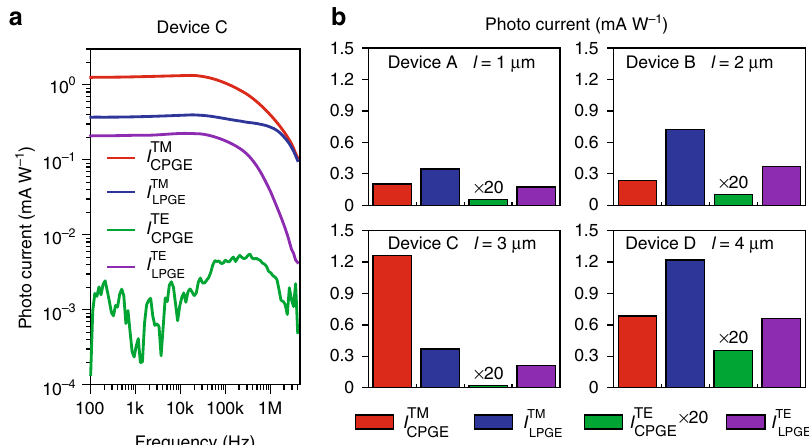
Fig. 4 Contributions of circular and linear photogalvanic currents. a Frequency response of the extracted CPGE and LPGE contributions of photogalvanic current for TM and TE modes in Device C. b CPGE and LPGE contributions for TM and TE modes in four devices with different TI lengths l between the electrodes from 1 to 4 µ m. A large variation of the ratio between the CPGE and the LPGE contributions is attributed to the high anisotropy of the LPGE, which is sensitivity to the crystalline orientation of the Bi 2 Se 3 fl ake to the